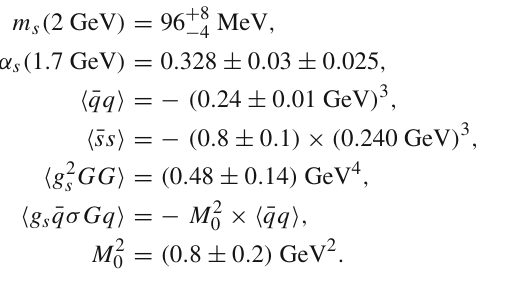
0 . The curves are obtained by taking